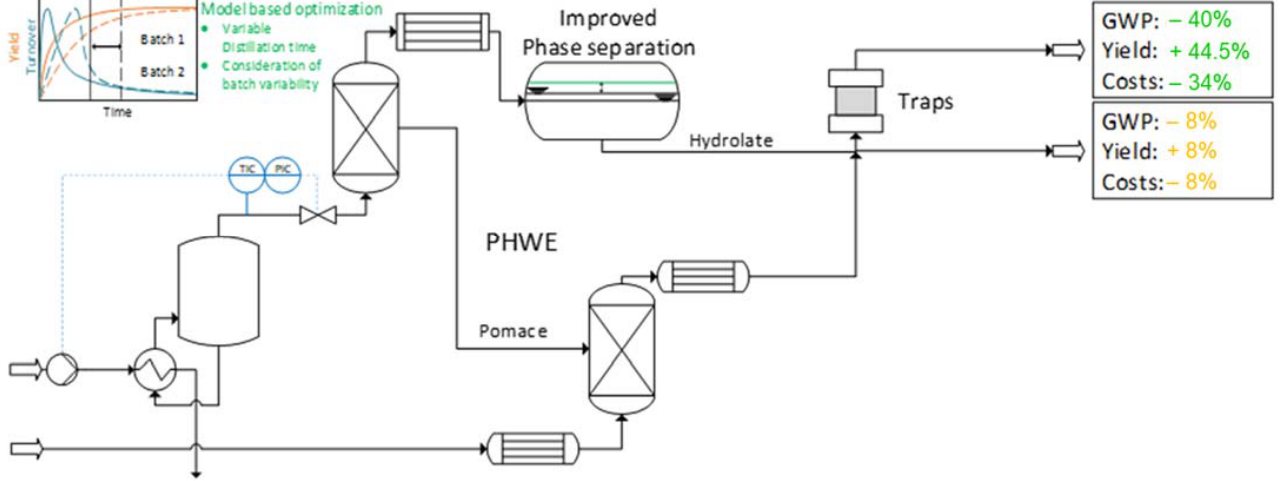
Figure 7. Process analytical technologies using the example of extraction with pressurized hot water extraction [17].